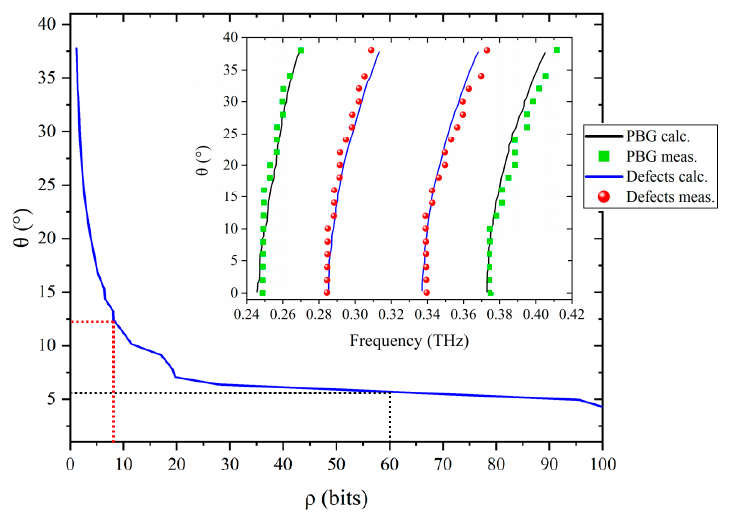
Figure 9. Maximum incident angle θ of the THz reading beam for the previous considered THID tag versus the coding capacity ρ . Insert: calculations (continuous lines) and measurements (dots) of the frequency shift of the PBG and defect peaks versus the incident angle of measurement.